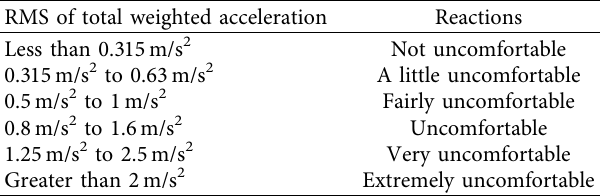
Table 1: Comfort reactions to vibration